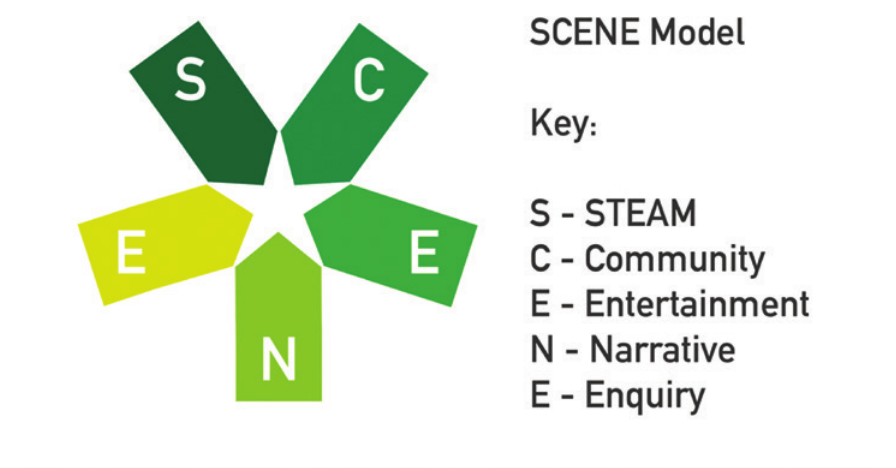
figure 1: The sceNe model (credit: